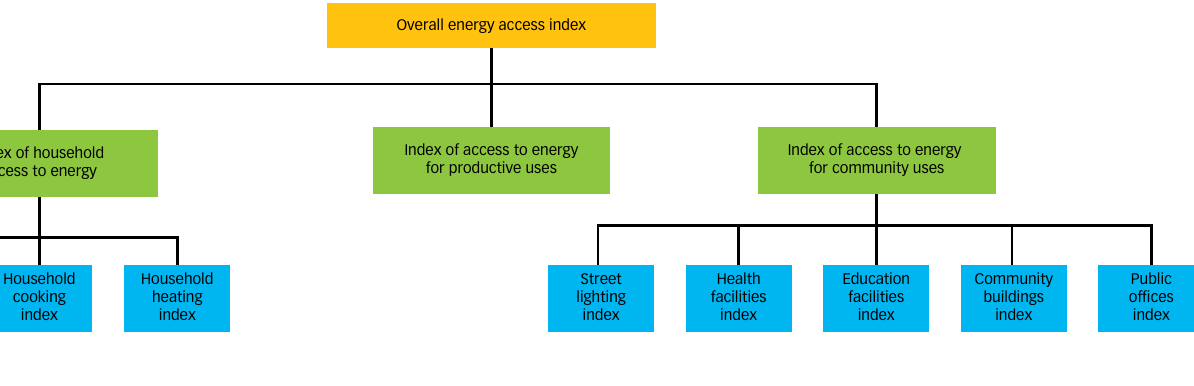
Figure 3. indices of energy access for households, enterprises, and community institutions